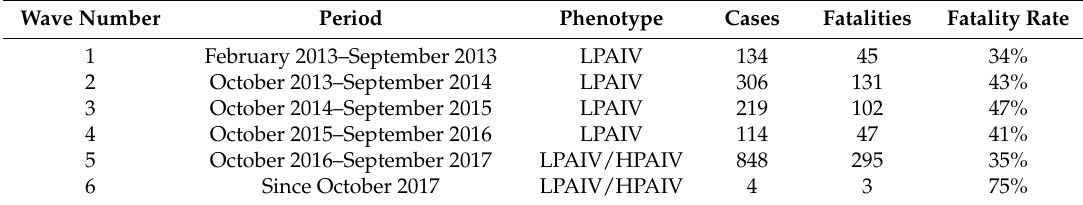
Table 3. Confirmed human infections/fatalities with LPAIV- or HPAIV H7N9 per